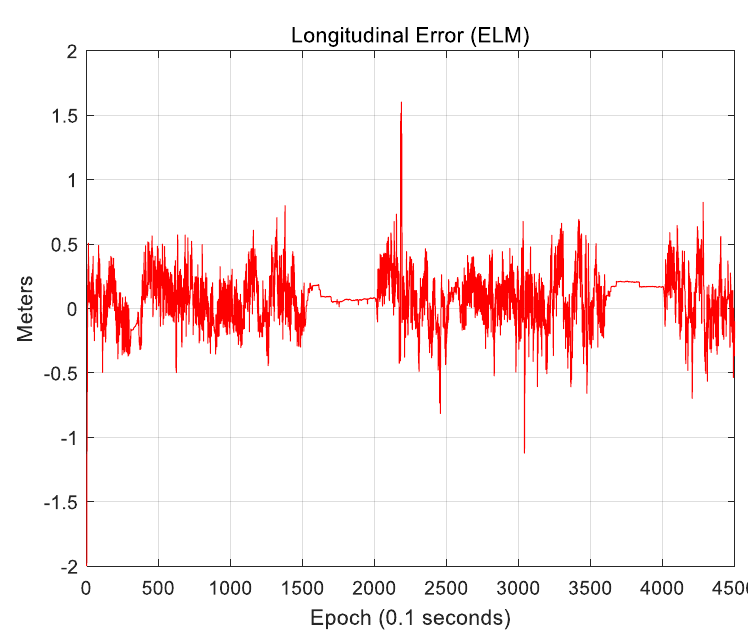
Figure 33. Lateral position error (ELM).